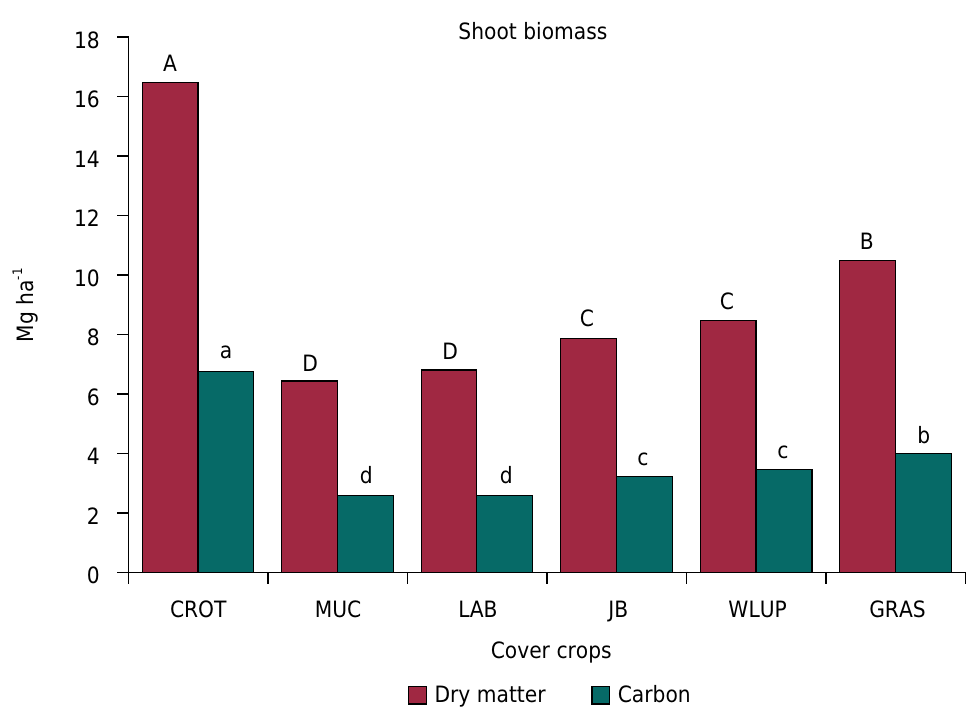
Figure 3. Dry matter production and carbon stock of the shoot biomass of different cover crops at 93 days after planting. CROT: Crotalaria juncea (sunn hemp); MUC: Mucuna aterrima (velvet bean); LAB: Dolichos lablab (lablab bean); JB: Canavalia ensiformis (Jack bean); WLUP: Lupinus albus (white lupine); GRAS: Urochloa maxima (Guinea grass) . Different letters, upper case for dry matter production and lower case for carbon stocks, indicate significant differences between cover crops by the Scott-Knott test at p<0.05.